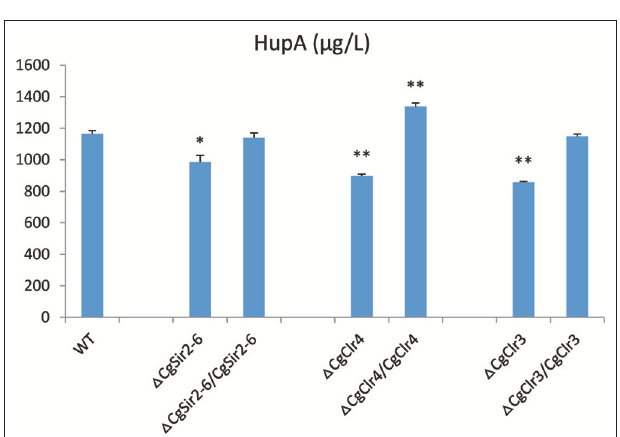
FIGURE 11 | Comparison of HupA production from culture extracts from wild type (WT) C. gloeosporioides Cg01, epigenetic gene knock-out mutants, and the corresponding retro-complementation strains. The experiment was performed in triplicate. Mean values and standard deviations are given. Asterisks above the bars denote significant differences in the measurements of the indicated strains compared to the WT. * p < 0.05; ** p <